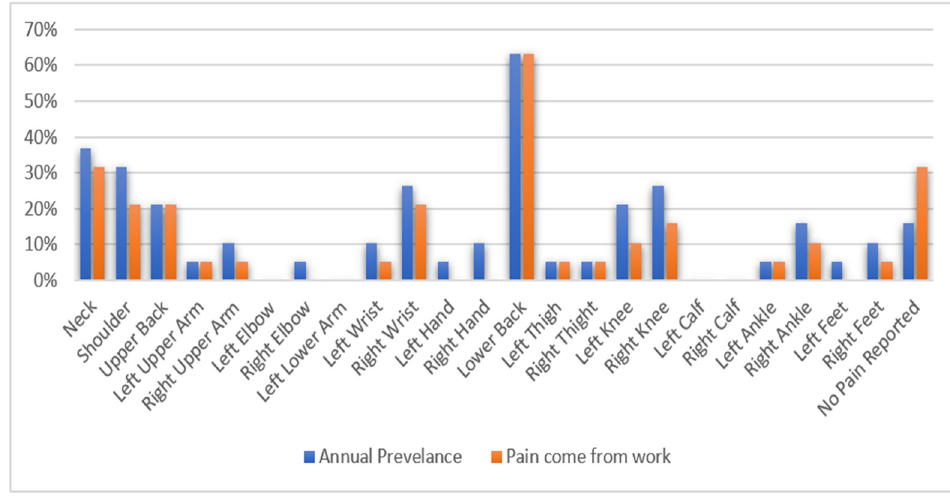
Figure 5. Percentage of respondents experiencing pain in any region of the body in the past 12 months and attributing pain to work.